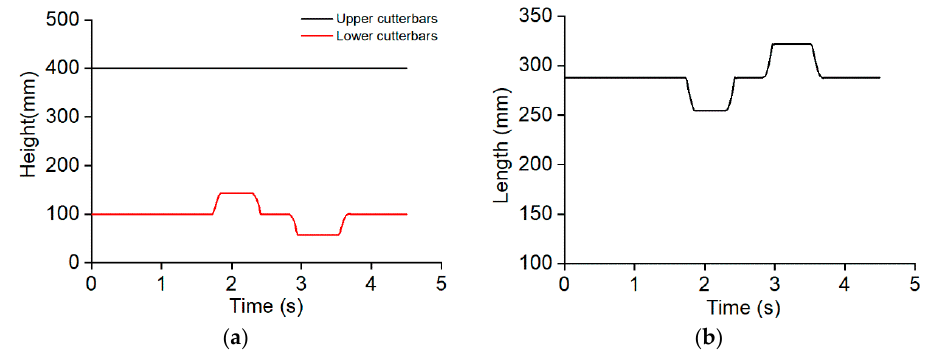
Figure 13. Motions of the components during harvesting. ( a ) Height change of the upper and lower cutterbars; ( b ) Length change of the L BA .